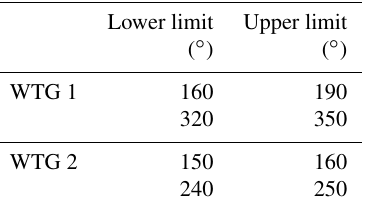
Table 1. Considered wind direction sectors per wake-generating turbine in the measurement campaign. Wind direction sectors with- out free inflow of the met mast and the turbine as well as measure- ments in the induction zone of another turbine are